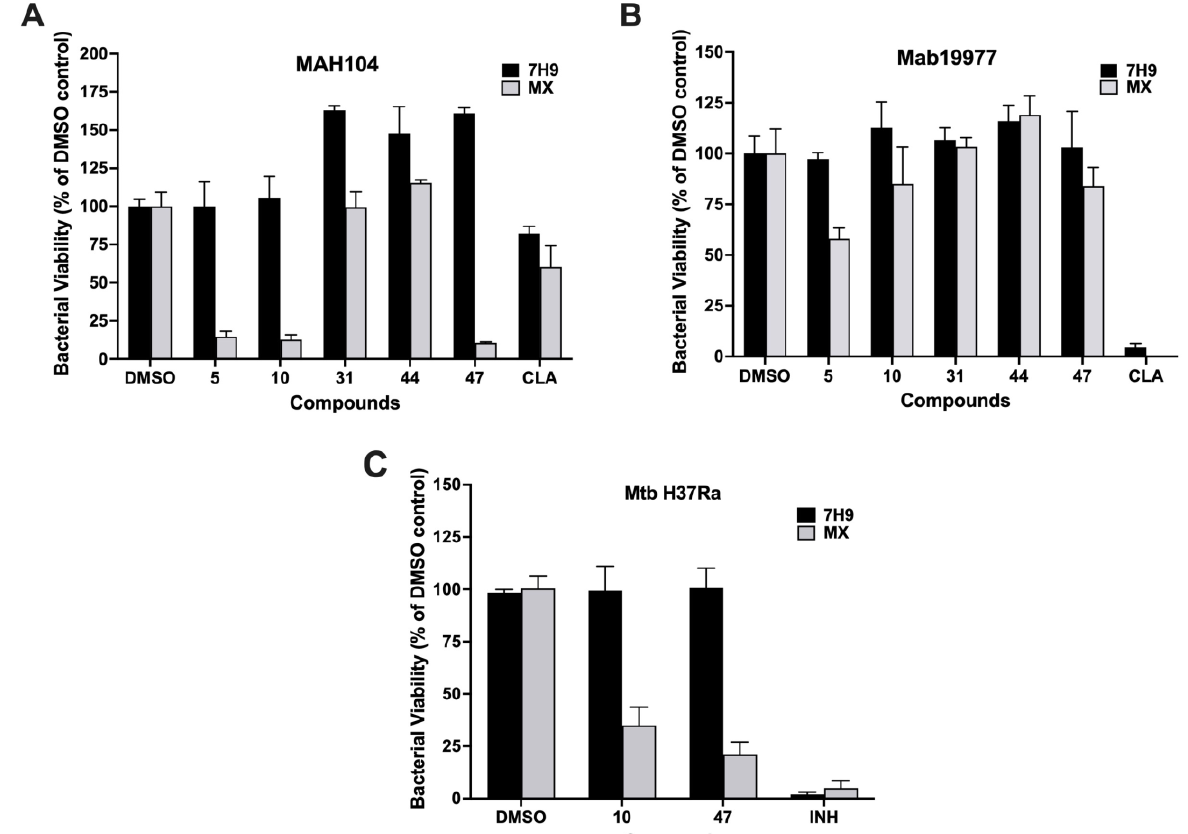
Figure 4. The efficacy of “intracellular” hit compounds against mycobacteria in the metal mix. The activity of compounds was evaluated against ( A ) MAH104, ( B ) Mab19977, and ( C ) MtbH37Ra in the MX to mimicking the metal concentrations and pH of 24 h phagosomes. Selected intracellular compounds were tested at 100 µ M concentration, and 1% DMSO was used as a positive control for bacterial growth. Treatment with clarithromycin and isoniazid at bactericidal concentrations served as negative controls for 100% growth inhibition in NTM strains and Mtb, respectively. Bacterial viability was analyzed by utilizing the resazurin reagent read at 530/590 nm excitation/emission filters on a fluorimeter (Tecan). Data represent the means ± standard deviations (SD) of three independent experiments performed in triplicates.